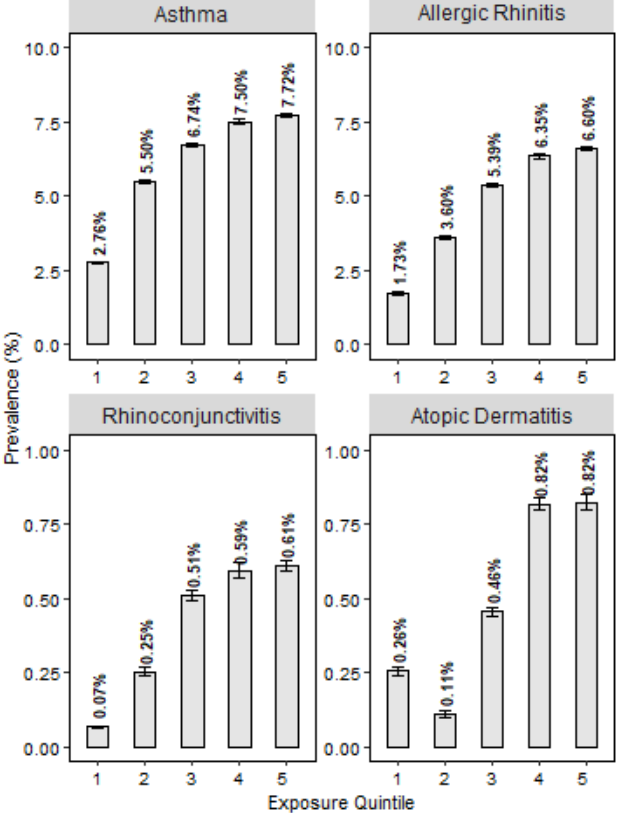
Figure 1. Crude prevalence and 95% confidence intervals for asthma, allergic rhinitis, rhino-conjunctivitis, and atopic dermatitis by NOx exposure quintiles for the study population. 1 = lowest NOx exposure category (< 5.63 ppb), 2 = (5.63–10.5 ppb), 3 = (10.5–14.7 ppb), 4 = (14.7–19.1 ppb) and 5 = (19.1–130 ppb).